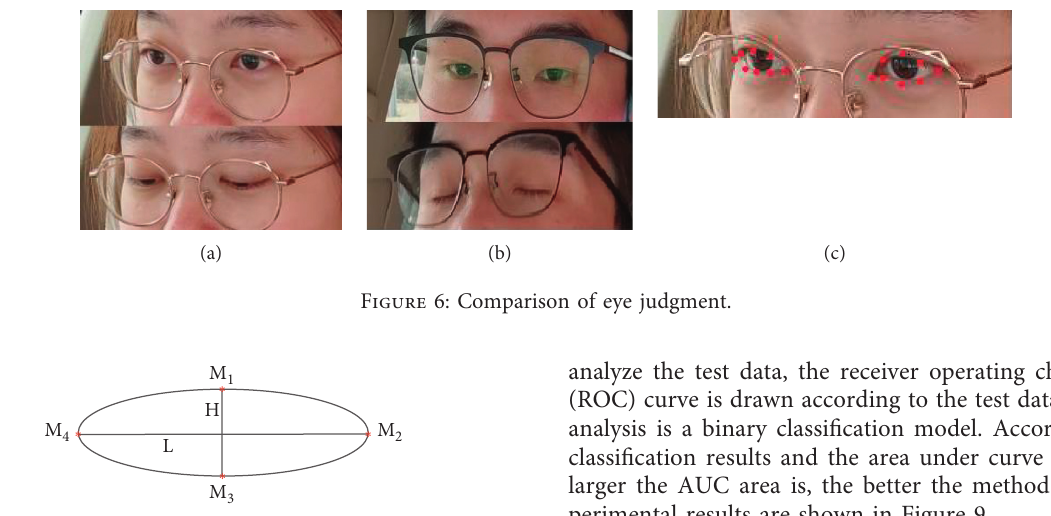
Figure 7: Schematic diagram of mouth.